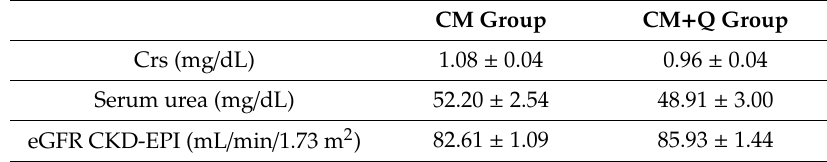
Table 3. Basal renal function in both groups. Crs, serum creatinine; eGFR, estimated glomerular filtration rate; CKD-EPI, Chronic Kidney Disease Epidemiology Collaboration. Data are expressed